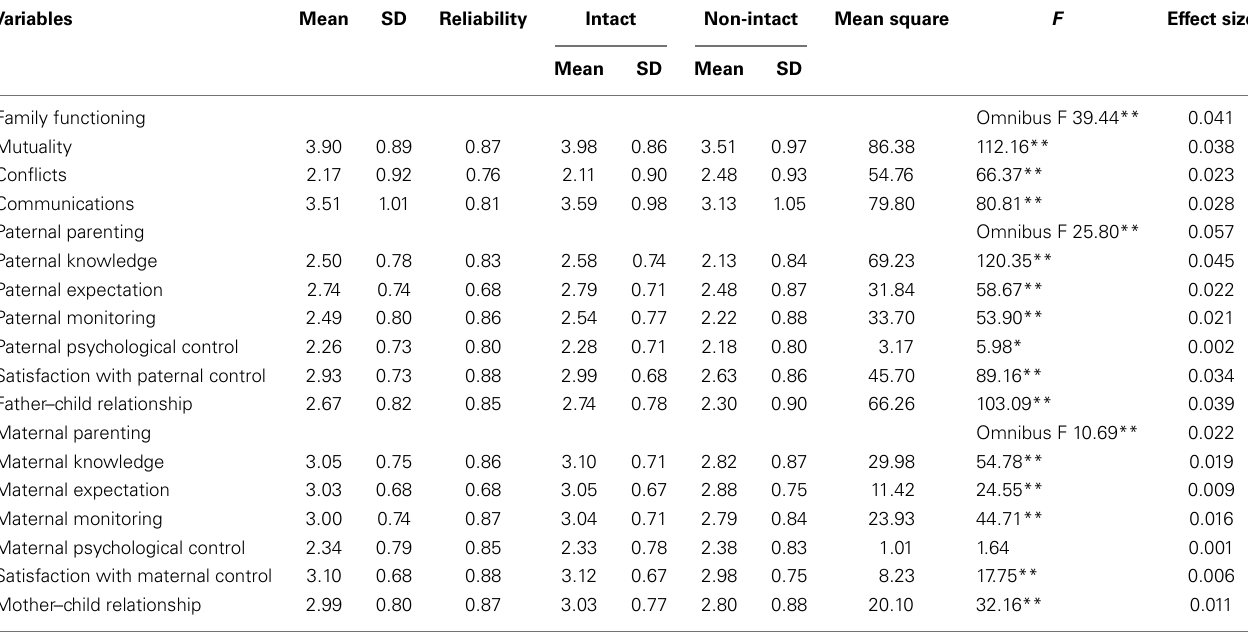
Table 1 | Effects of family intactness on family functioning, parental control, and parent–child relational qualities .